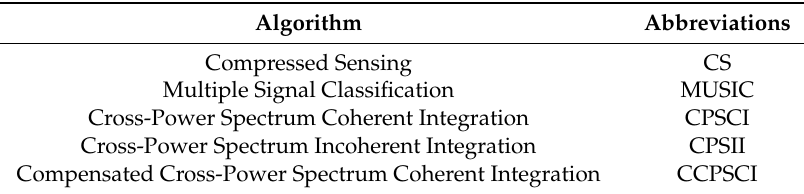
Table 1. Methods for spectral estimation and their abbreviations.